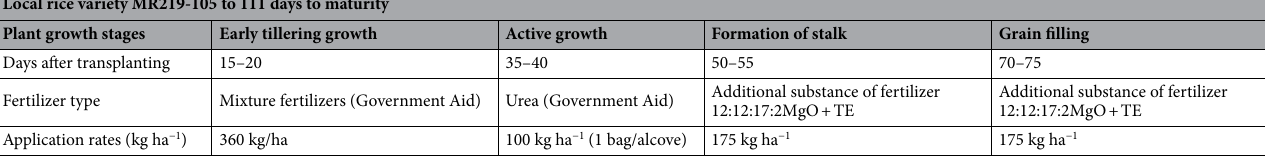
Table 3. Fertilization schedule recommended by Muda Agricultural Development Authority, 2015 for rice variety MR219. The mixture fertilizers (Government Aid) = 17.5 N: 15.5 P 2 O 5 : 10 K 2 O.